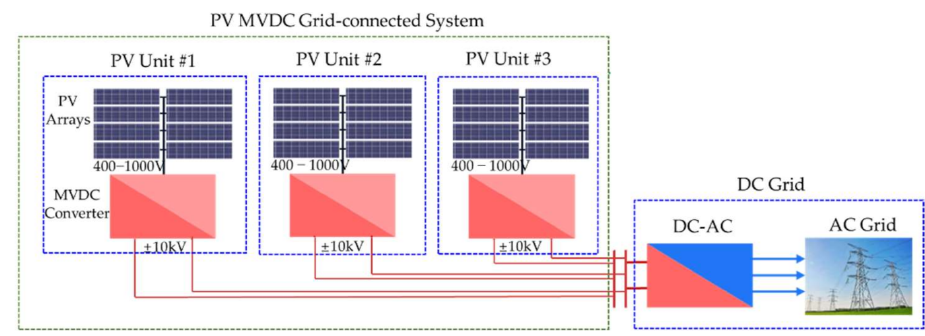
Figure 1. PV MVDC grid-connected